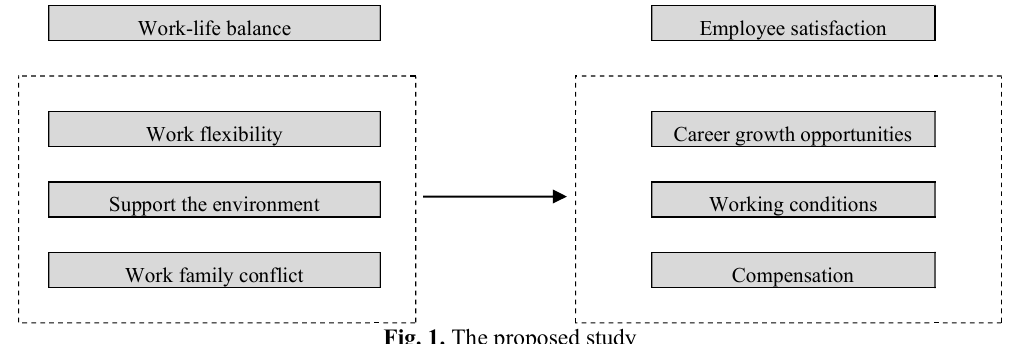
Fig. 1. The proposed